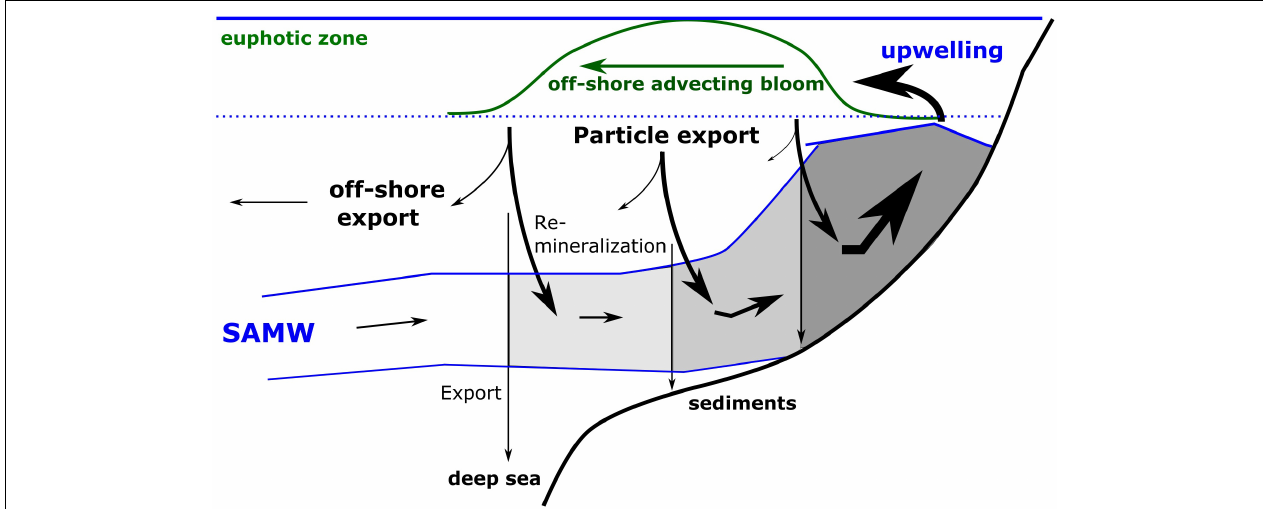
FIGURE 2 | Schematic illustration of nutrient trapping. The figure shows the supply of Sub-Antarctic Mode Water (SAMW), its upwelling at the coast, the development of an offshore advecting bloom due to the utilization of upwelled nutrients and the export of organically bound nutrients within sinking particles. The remineralization of organic matter within the onshore flowing SAMW increases the nutrient concentrations and lowers oxygen concentrations in the upwelling water and prevents the export of nutrients into the open ocean, the deep sea and sediments. The darkening gray areas indicate decreasing oxygen and increasing nutrient